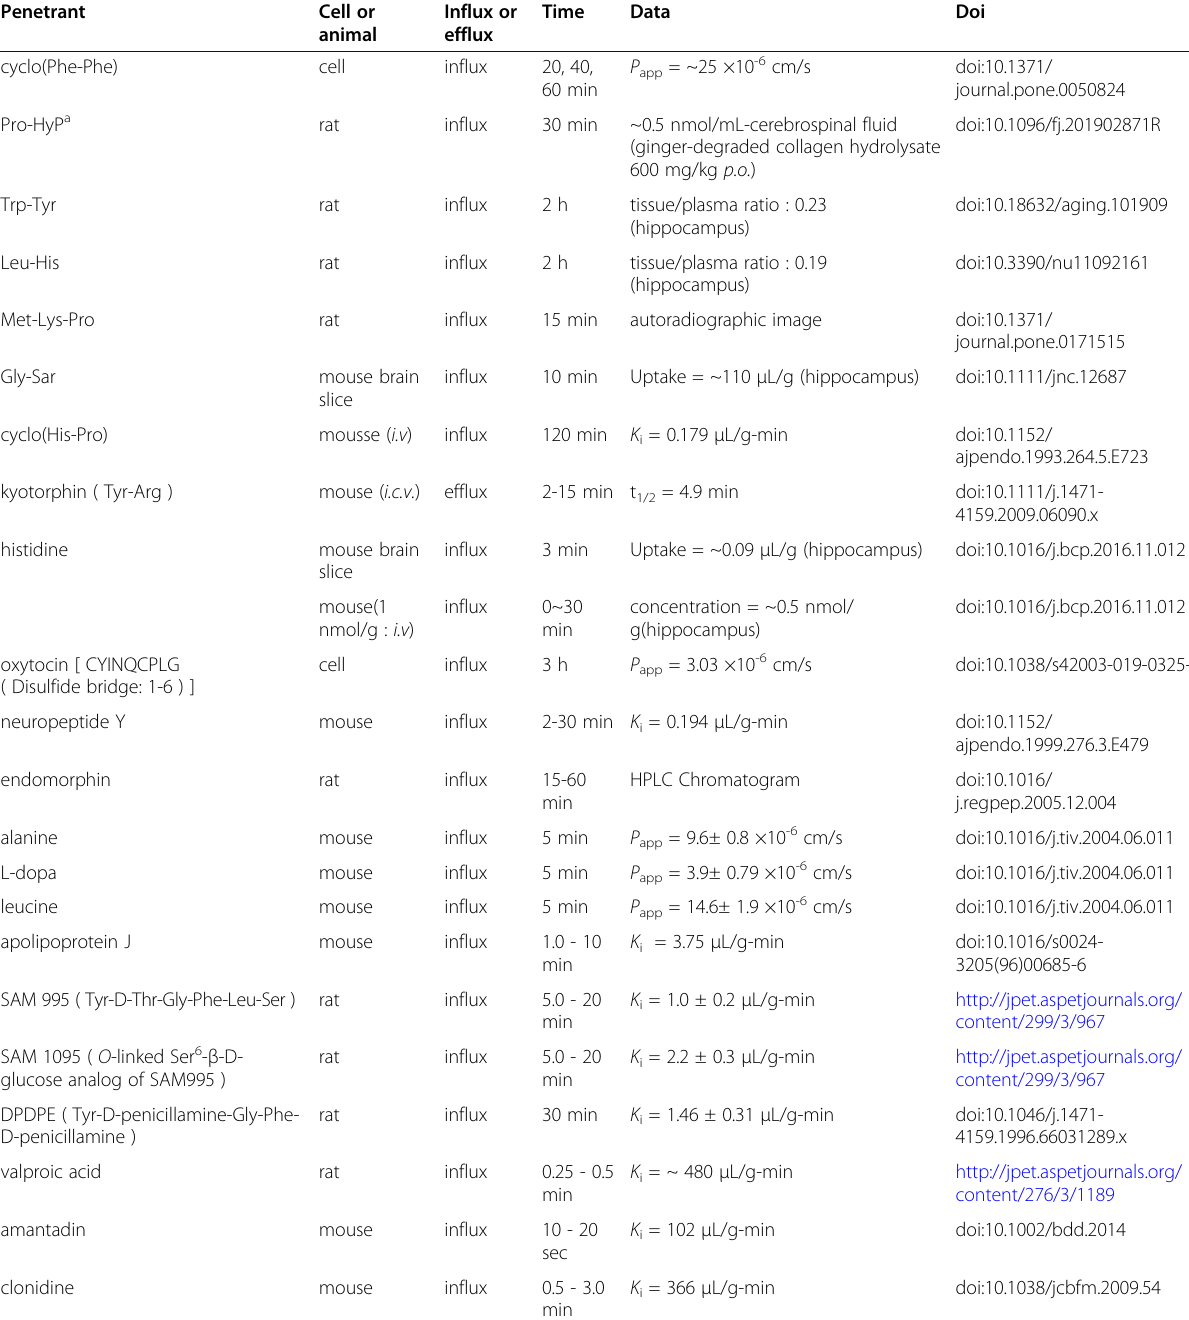
Table 1 The transportability of peptidic compounds across the blood-brain barrier Penetrant Cell or